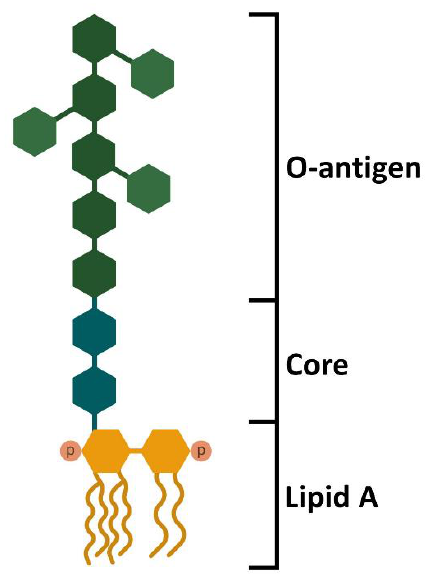
Figure 1. Structure of E. coli LPS. LPS is a complex molecule made of lipids and sugars. The structure is divided into three different domains. The lipid A moiety is localized into the outer membrane of the Gram-negative bacteria and is responsible for TLR4 interaction through the phosphate groups and the acyl chains. The central core is composed of oligosaccharide and links the lipid A moiety with the O -antigen. The O -antigen is made of polysaccharides and can reach over 100 repeats of sugars. The complexity and the high number of repeats allow a more stringent barrier against antibody recognition. Furthermore, the O -antigen allows differentiating bacterial species and serotypes